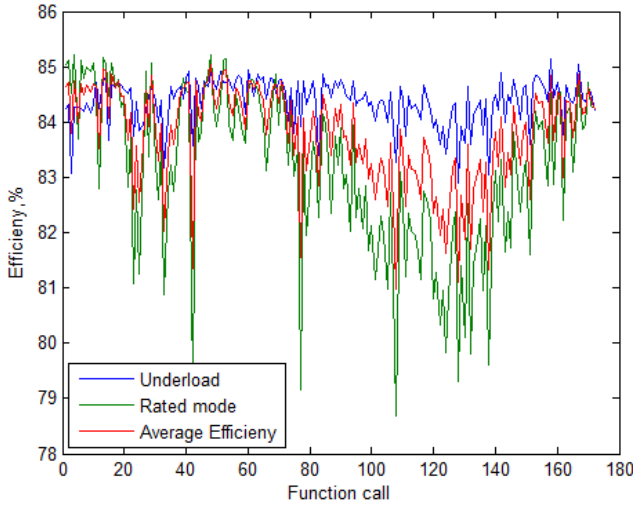
Figure 8. Change of the motor efficiency during the optimization.